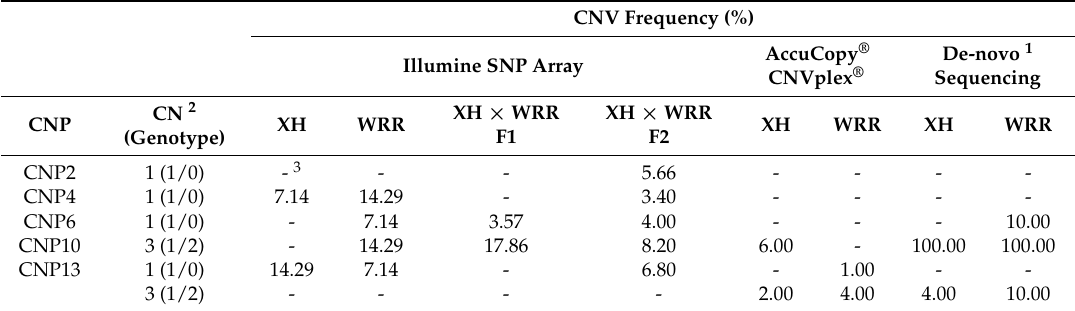
Table 2. Detection of copy number variations (CNVs) in candidate